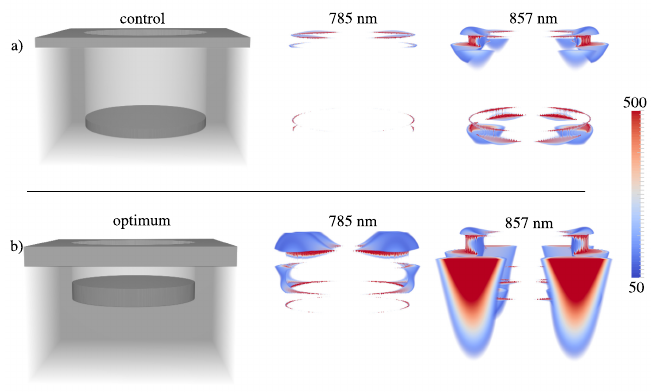
Figure 4. Plot of optimization factors ( O . F . = G 4 ( c ) periodicity, and ( d ) metal thickness were sequentially varied. The final optimization factor is 6.0. Dashed lines correspond to spline interpolation between data points and are meant for ease of visualization only.